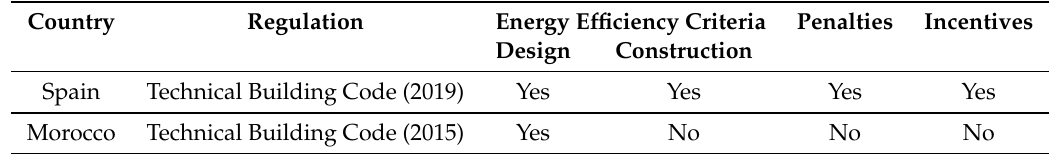
Table 2. Spanish and Moroccan legislation on energy efficiency: comparison.